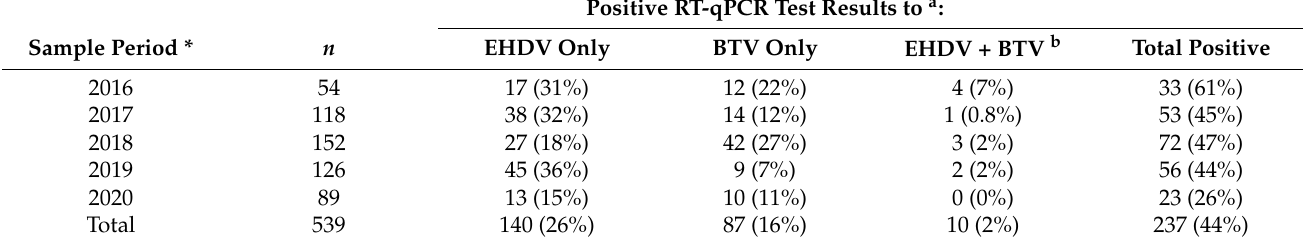
Table 2. Dead farmed white-tailed deer testing positive to epizootic hemorrhagic disease virus (EHDV) and bluetongue virus (BTV) by RT-qPCR from 2016–2020. Passive surveillance for EHDV/BTV in post-mortem specimens from farmed Florida WTD is ongoing.